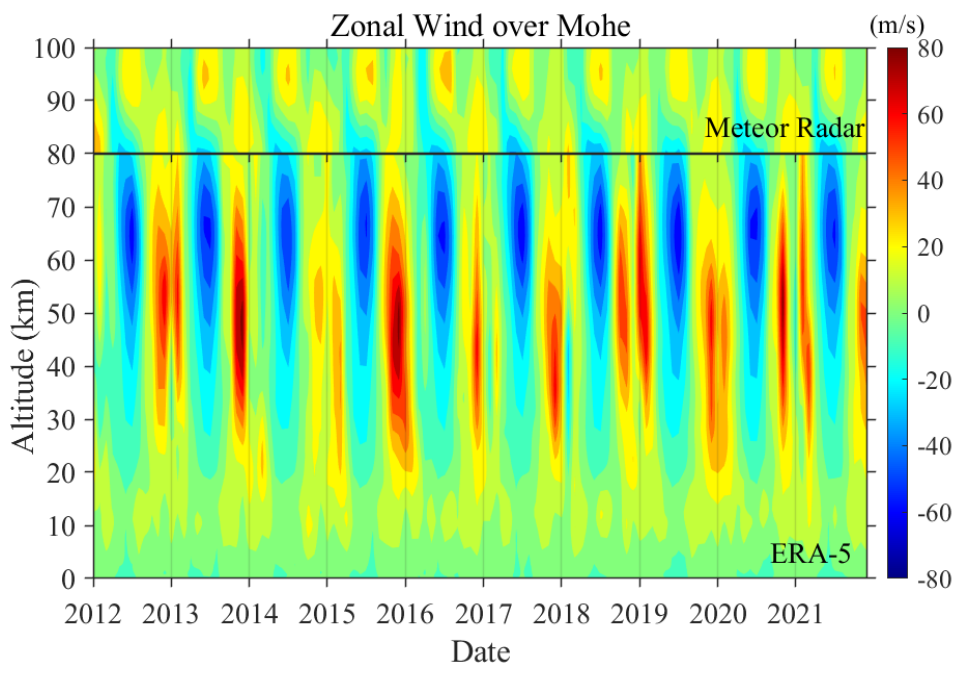
Figure 12. Monthly mean zonal wind over Mohe, from 2012 until 2021. The wind profile below 80 km is provided by the ERA-5 re-analysis data.